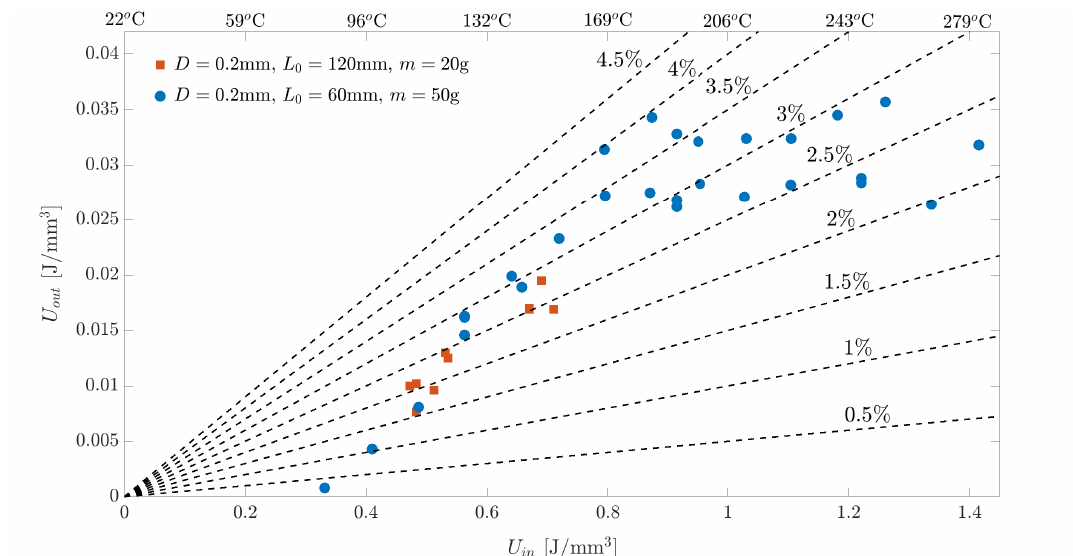
Figure 11. Energy efficiency of a clamp-free actuator. Mechanical work output, U out , presented as a function of the electrical input energy, U in , based on Equation (3). The dashed lines represent different energy efficiencies based on the ratio between the specific output and input